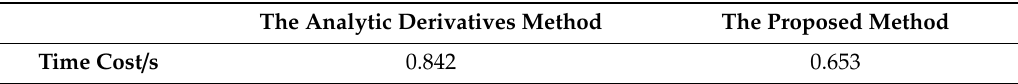
Table 2. Comparison of the Time